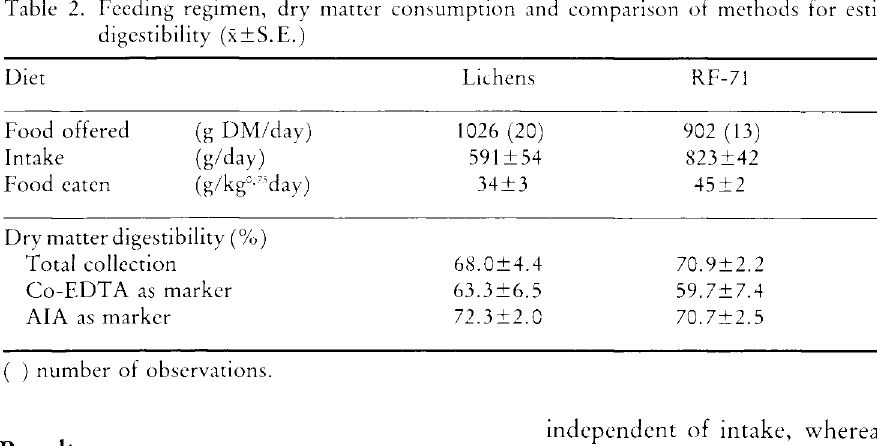
Table 2. Feeding regimen, dry matter consumption and comparison of methods for estimating dry matter digestibility (x±S.E.)